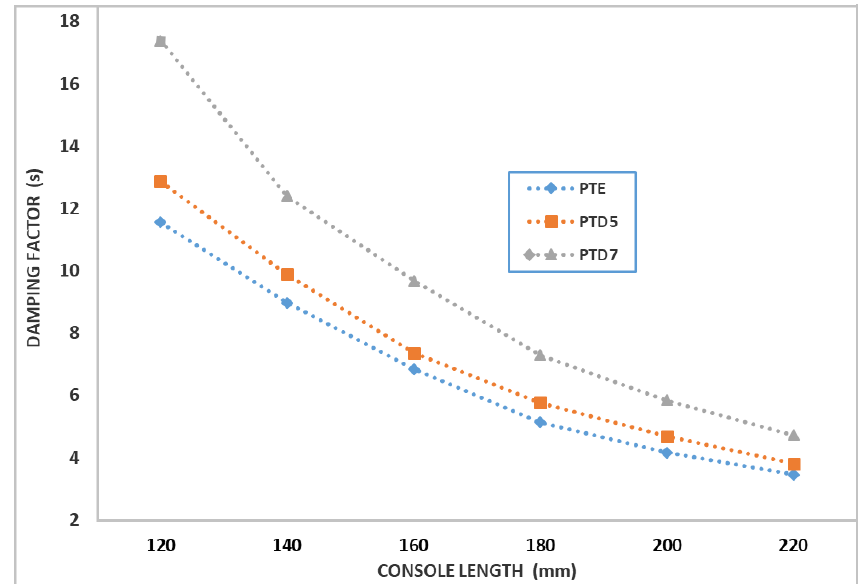
Figure 10. Variation of the damping factor according to the console length of the bar, for representative specimens from the PTE, PTD5 and PTD7